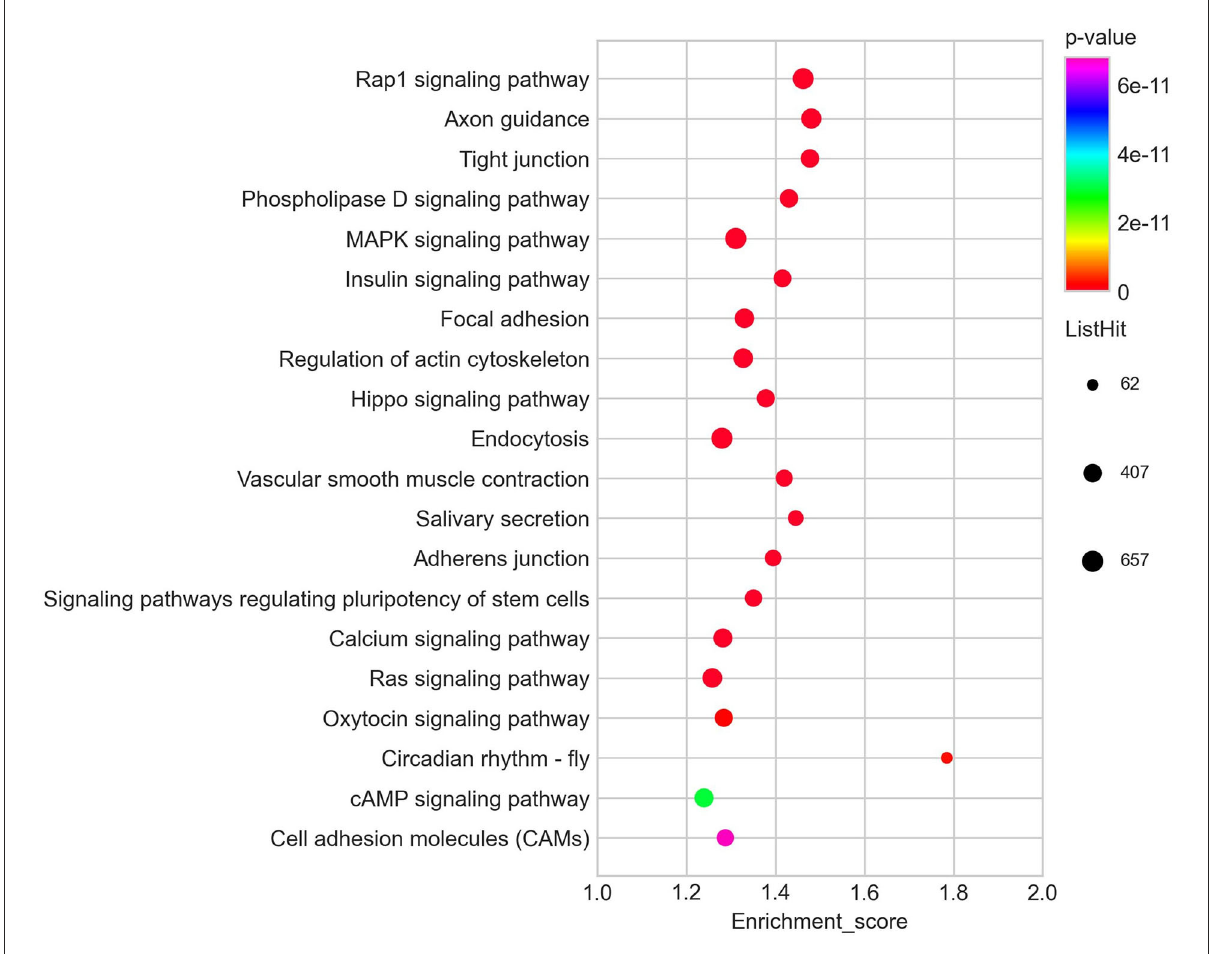
FIGURE4 Top 20 KEGG pathways of predicted target genes of differentially expressed